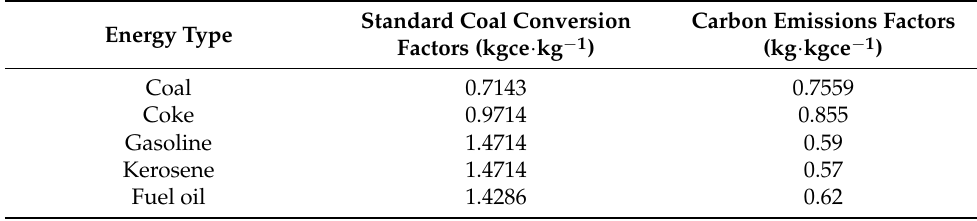
Table 2. The conversion factors and carbon emissions